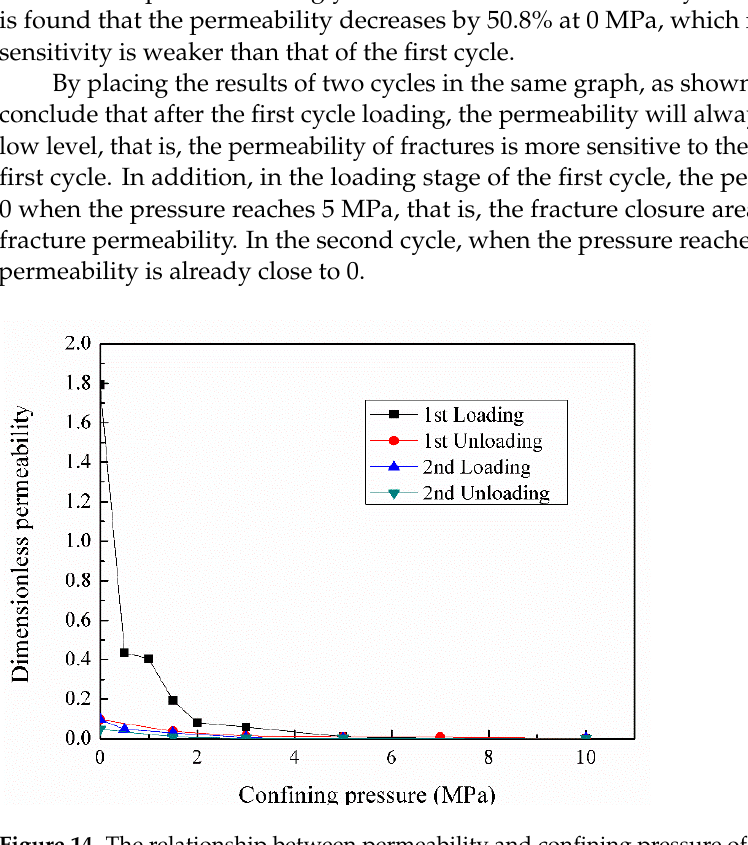
Figure 13. The relationship between permeability and confining pressure: ( a ) the first cycle, ( b ) the second cycle.